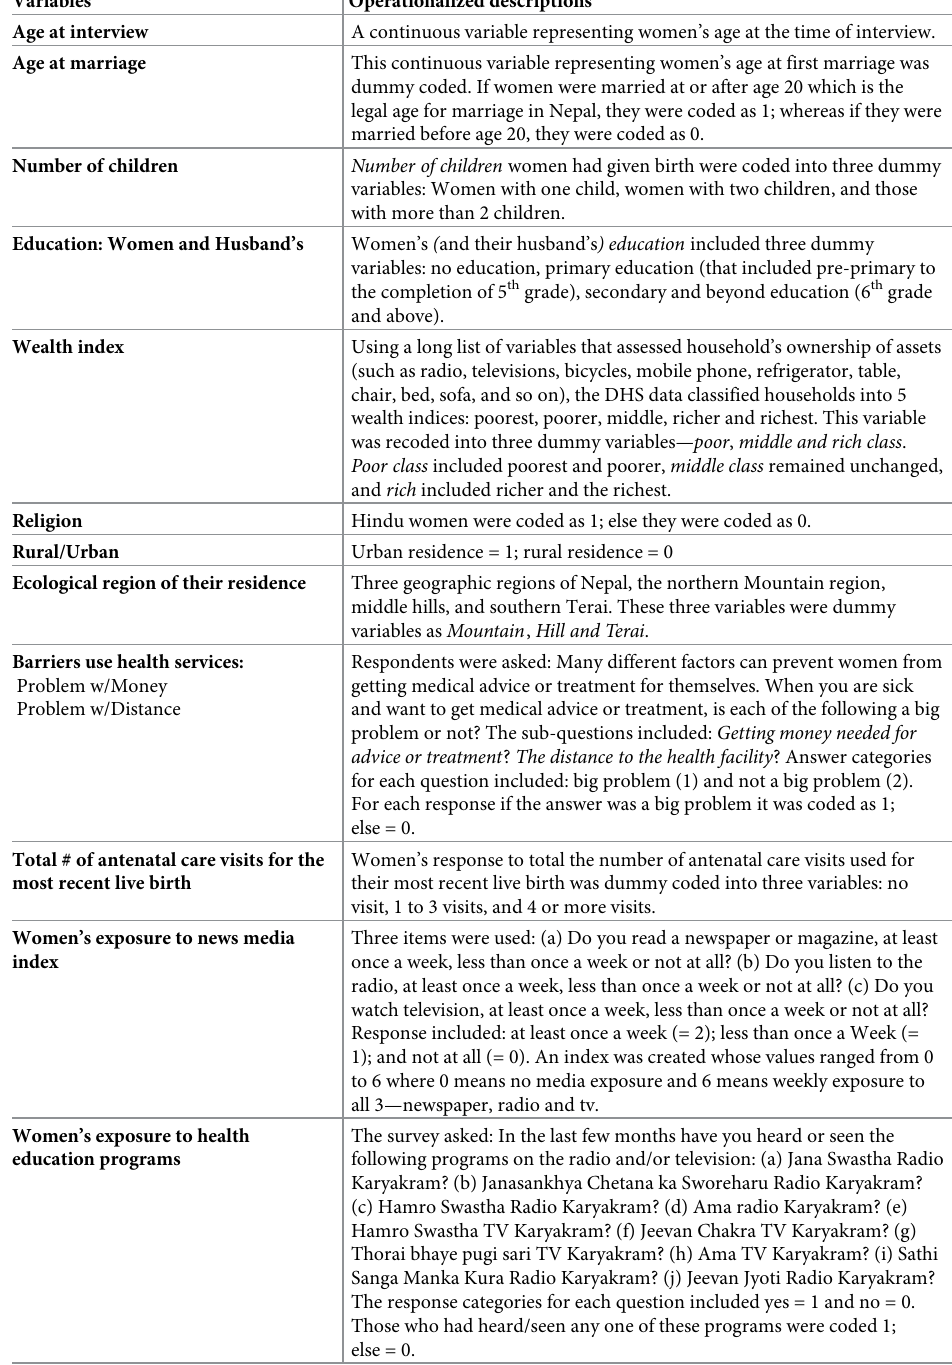
Table 1. Operational definitions of co-variates used in the current